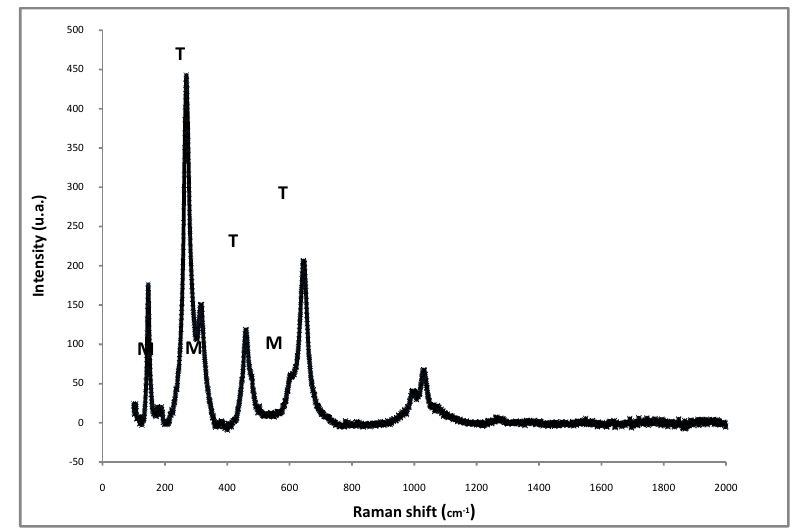
Figure 2. Raman spectra of Pt/SZ catalyst after calcination at 873 K.